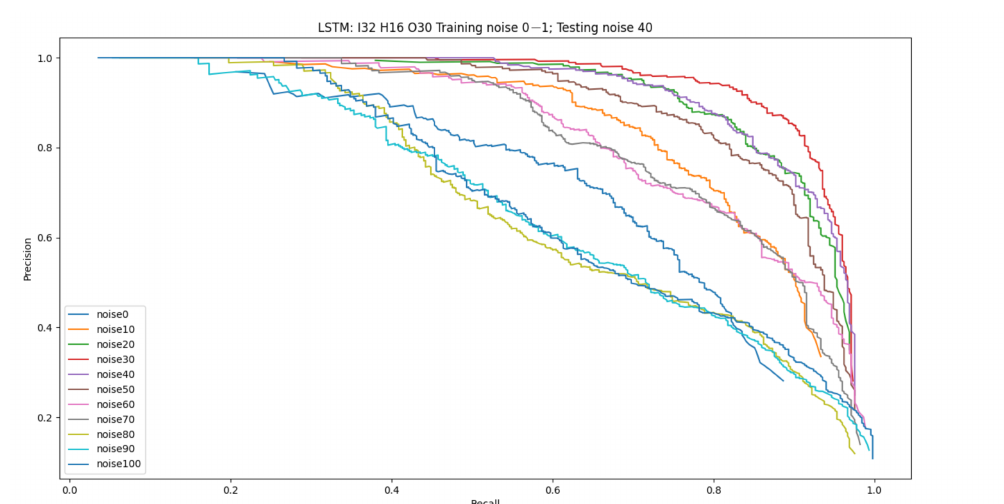
Figure 7. Precision and recall curves for the models presented in Table 6 evaluated on a testing set with Gaussian noise of zero mean and 40 cm of standard deviation.